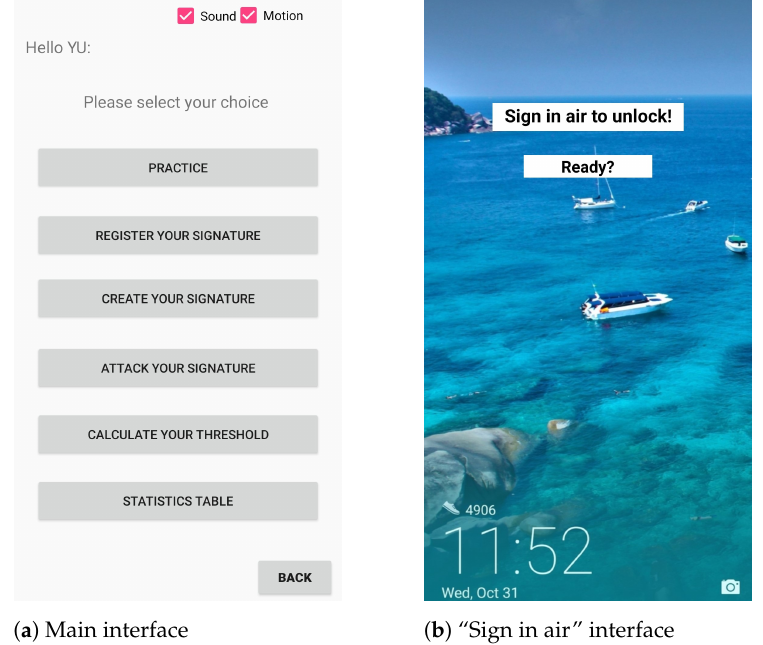
Figure 13. Data collection application user interface